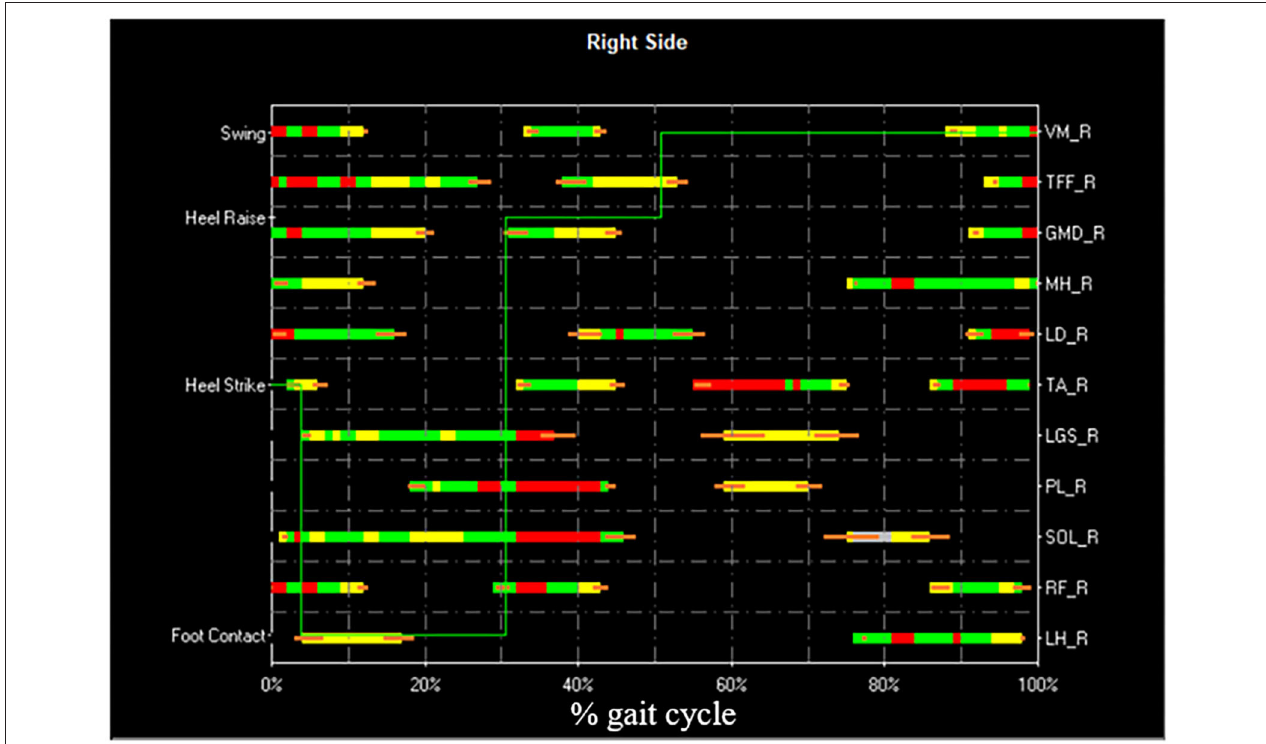
FIGURE 5 | Example of STEP32 interface showing the results of the sEMG analysis. After the selection of the HFPS cycles reported in Figure 4 , the most frequent activation patterns are shown for Vastus Medialis (VM), Tensor Fasciae Latae (TFF), Gluteus Medius (GMD), Medial Hamstring (MH), Longissimus Dorsii (LD), Tibialis Anterior (TA), Lateral Gastrocnemius (LGS), Peroneus Longus (PL), Soleus (SOL), Rectus Femoris (RF), Lateral Hamstring (LH) of the right side (most affected side of the PD subject). For each muscle, the orizontal bars represent the average activation intervals of the most frequent activation modality. The normalized amplitude is color-coded in three levels: high amplitude in red, medium amplitude in green, and small amplitude in yellow. Orange bars represent the standard error on the onset/offset detection of the activation intervals. The basographic signal is also shown superimposed (green line).